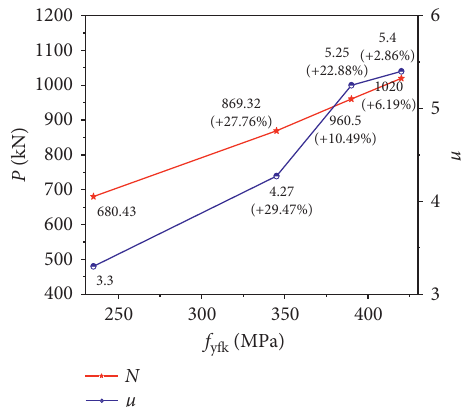
Figure 19: Relationships between P